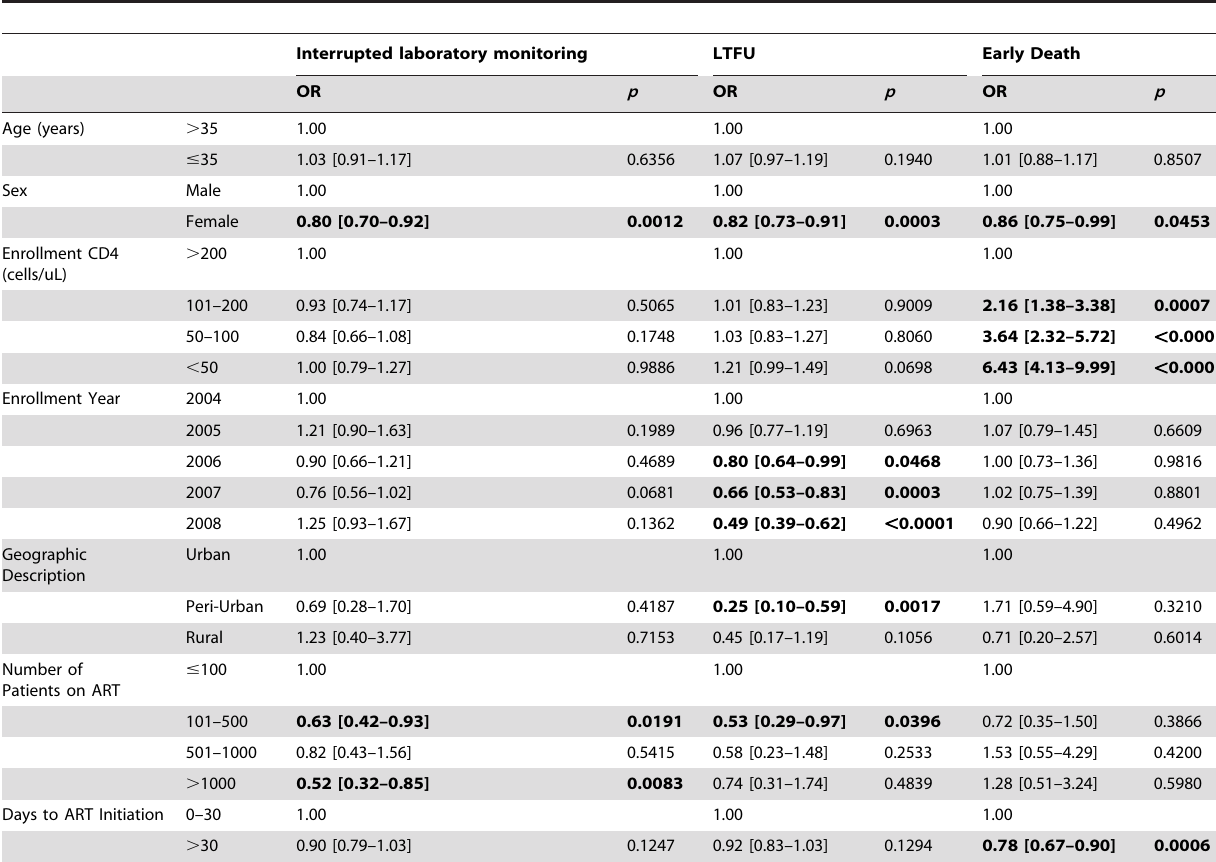
Table 2. Factors associated with interrupted laboratory monitoring, LTFU, and early death in multivariate analysis*.